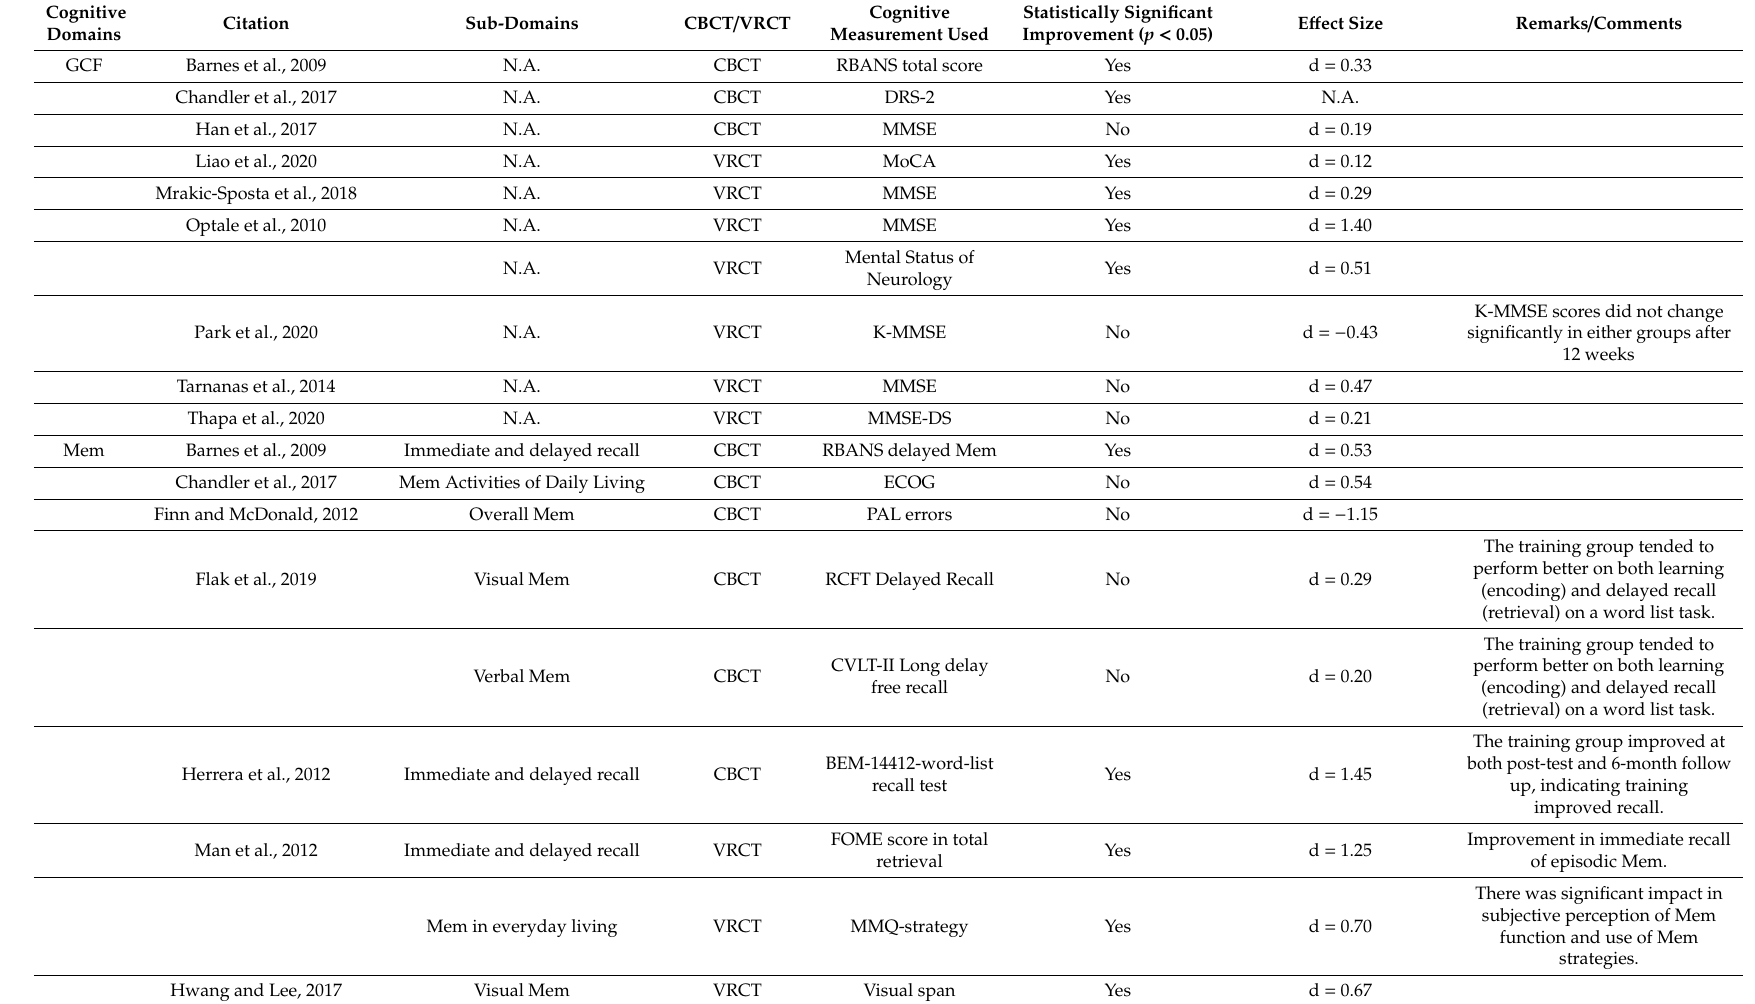
Table 2. Results of the five specific cognitive